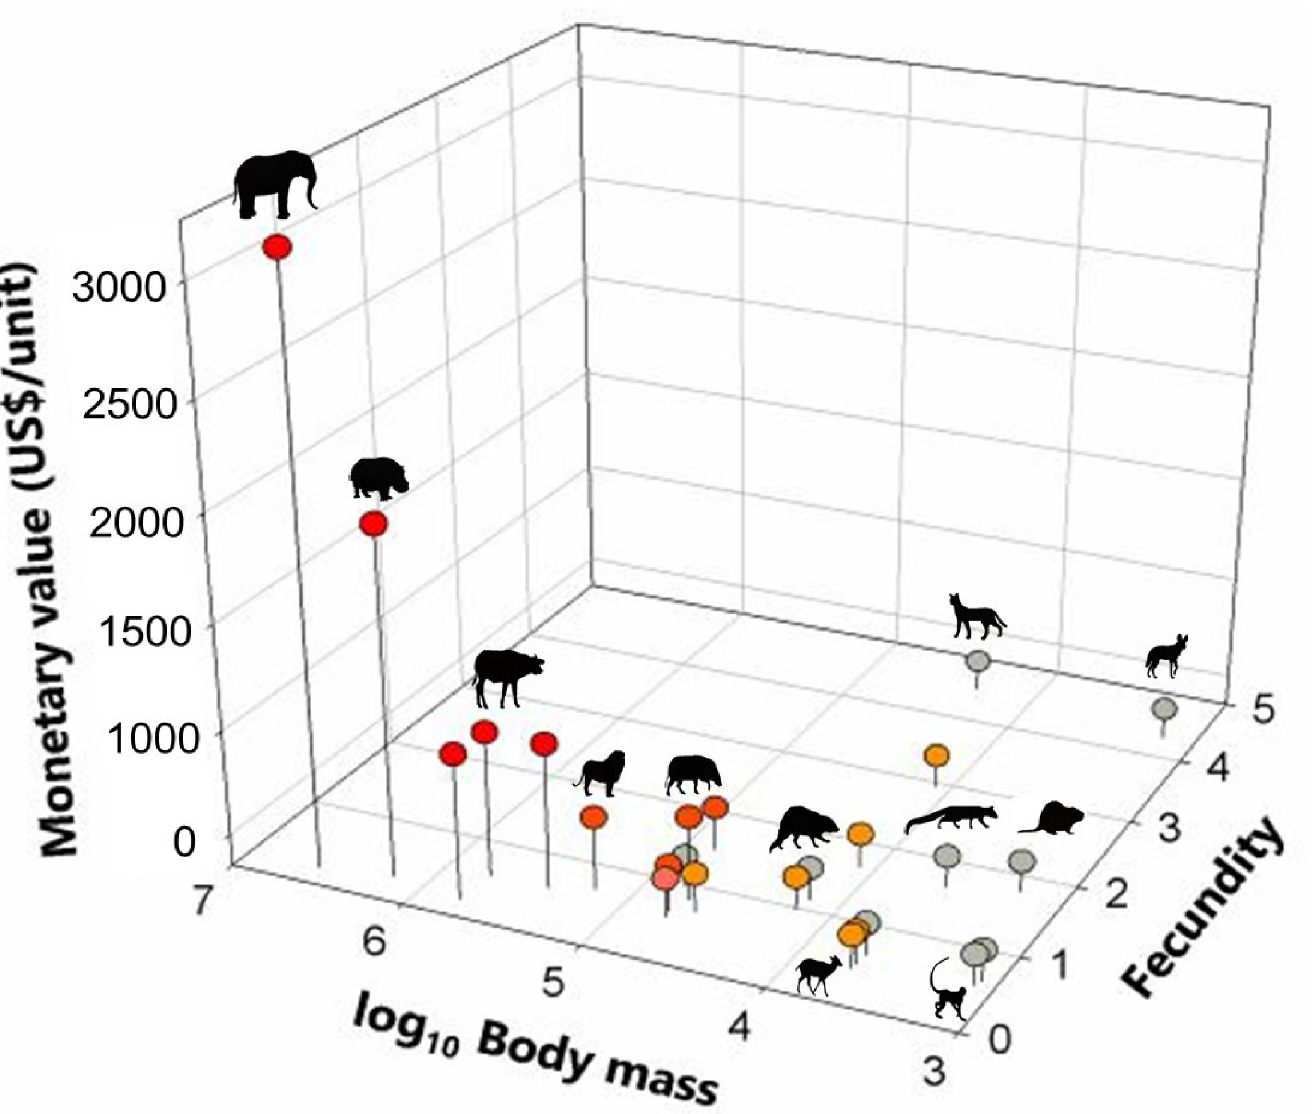
Fig 5. Monetary values obtained from each prey item traded in the local market. Mammal species are ordered along different axes i) z: From top to bottom from least to most profitable; ii) x: From left to right from largest to smallest; and iii) y: From left to right from lowest to highest fecundity rate. Warmer colours indicate higher offtakes in monetary values. Dollar values were based on the 2017 Kwanza conversion rate (US$1 = 165 Kwanzas).